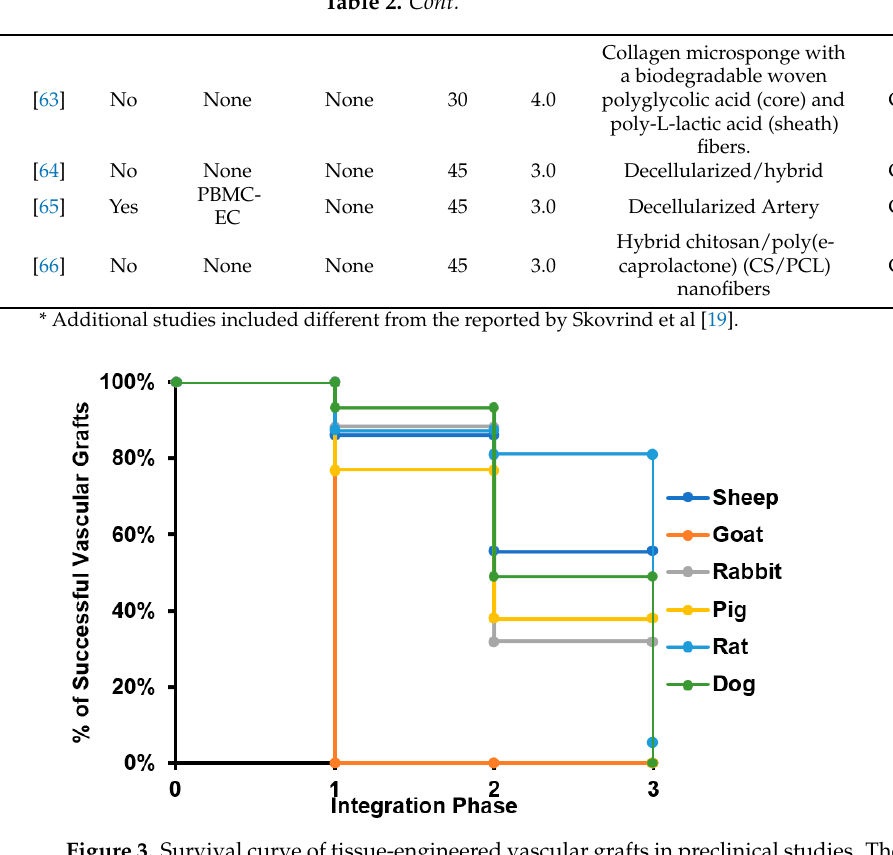
Figure 3. Survival curve of tissue-engineered vascular grafts in preclinical studies. The survival curve presented starts with all the specimens participating in preclinical studies for each of the species evaluated. When a given number of individuals does not overcome a given phase of the integration process, it is subtracted from the total number of specimens participating, reducing the percentage of animals surviving the